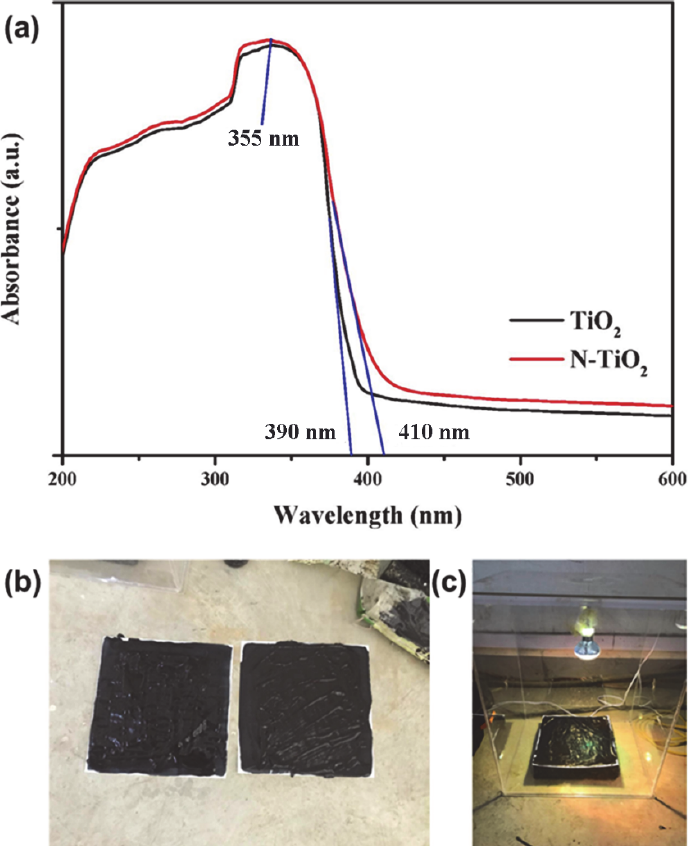
Figure 5. ( a ): UV ‐ Vis DRS of TiO 2 and N ‐ TiO 2 . Experimental device ( b ): Cardboard coated with emulsified asphalt and ( c ): Simulating the experimental process of solar irradiation. (Reprinted with permission from Ref. [92]. Copyright 2021, copyright Elsevier).